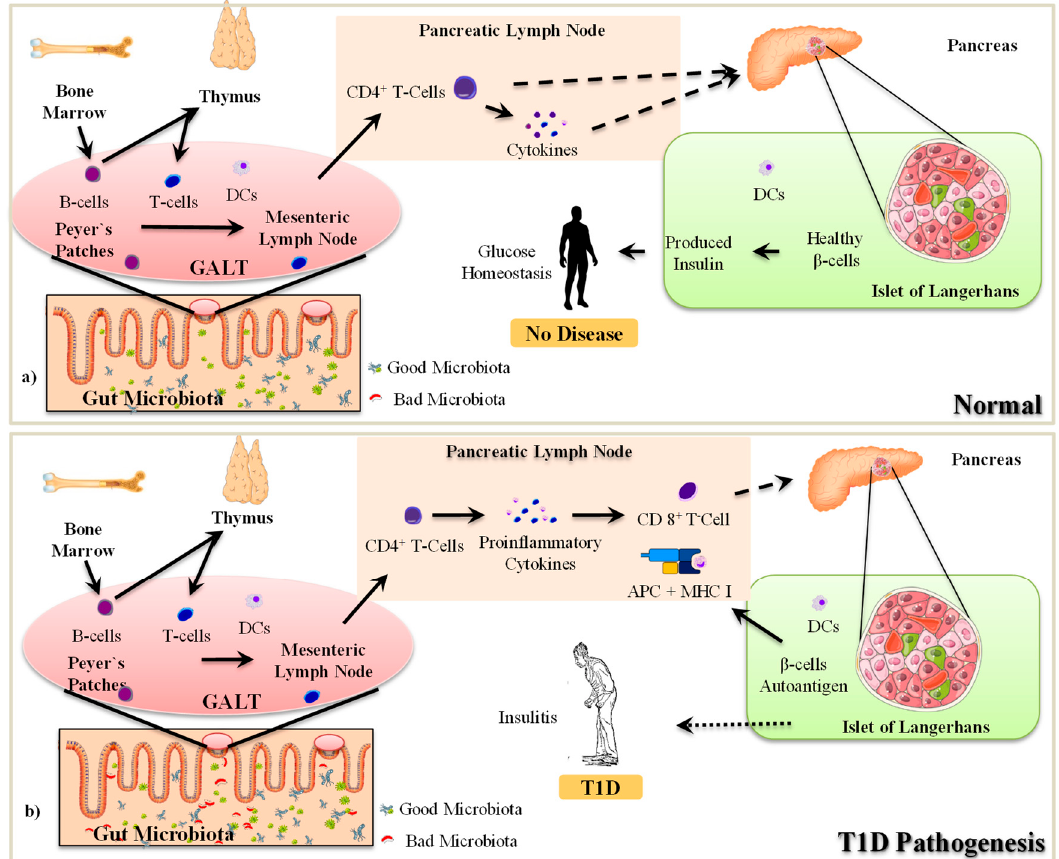
Figure 2. Mechanisms involved in the pathogenesis of T1D. APC: Antigen presenting cell; DCs: Dendritic cells; GALT: Gut Associated Lymphoid Tissue; MHC: Major Histocompatibility Complex; CD 8 + T-Cell: Cytotoxic T lymphocytes; CD4 + T-Cells: Helper T lymphocytes; T1D: Type-1-Diabetes.